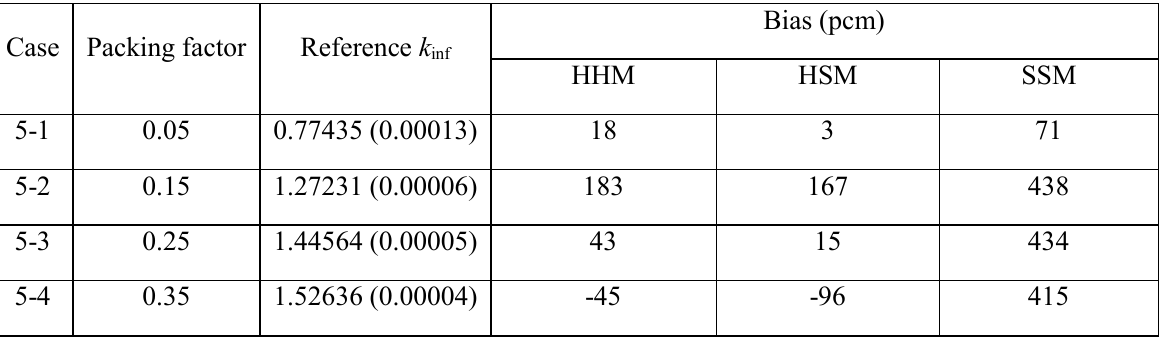
Table IX Comparison of k with different packing factors with the pin radius to be 0.5018 inf